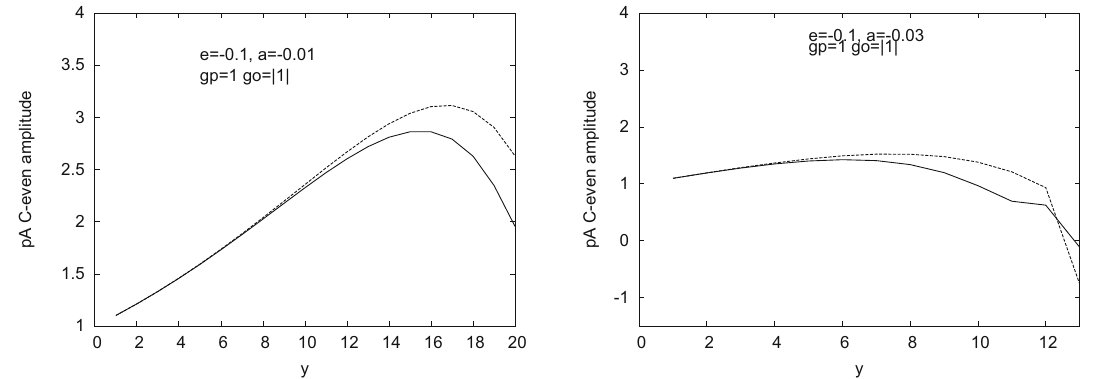
Fig. 2 pA C-even amplitudes for at different rapidities for μ p = 0 . 1, λ = 0 . 01 , 0 . 03 and g P = | g O | = 1. The upper curves correspond to summation of the fan diagrams